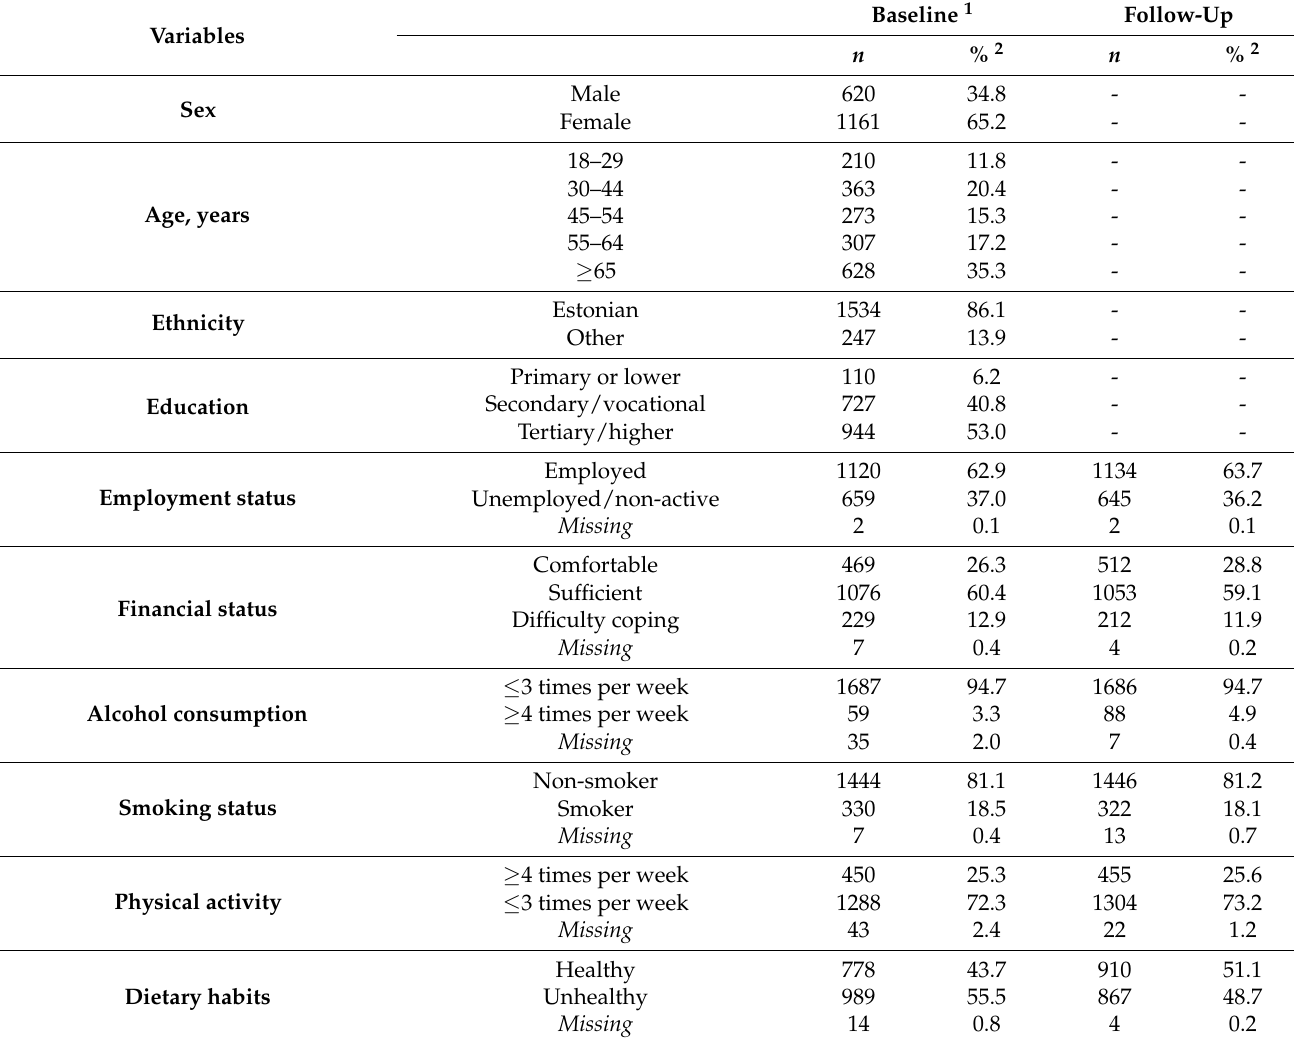
Table 1. Demographic, socio-economic and health behaviour characteristics of study sample at baseline and follow-up, Estonia